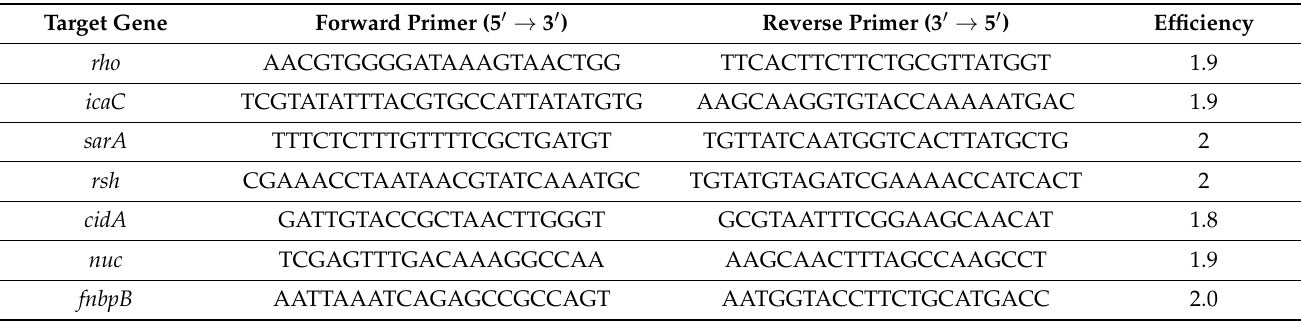
Table 1. Nucleotide sequences of primers used for RT-qPCR and efficiency for each primer